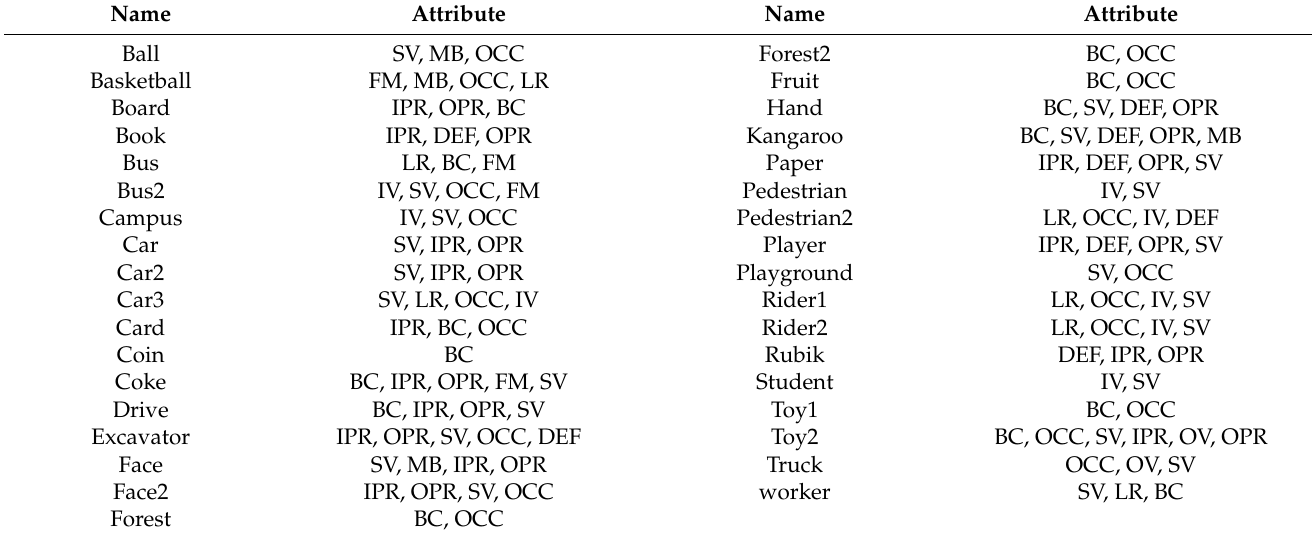
Table 1. Sequence names and attributes of the testing set. The challenge attributes of 35 image sequences are included.